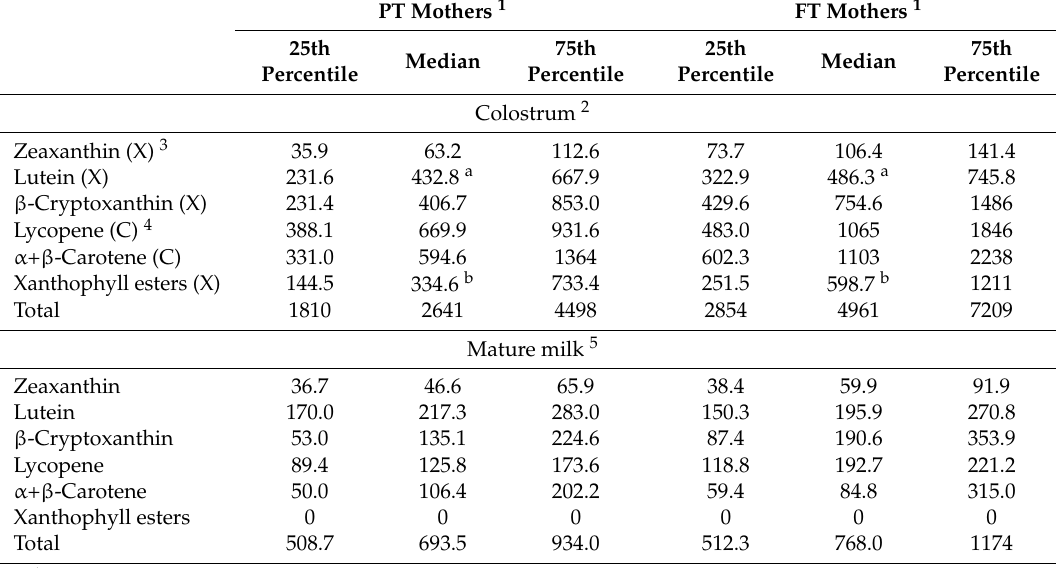
Table 1. Carotenoid content in colostrum and mature milk of preterm (PT, n = 70) and full-term (FT, n = 70) mothers. Data are expressed in nM